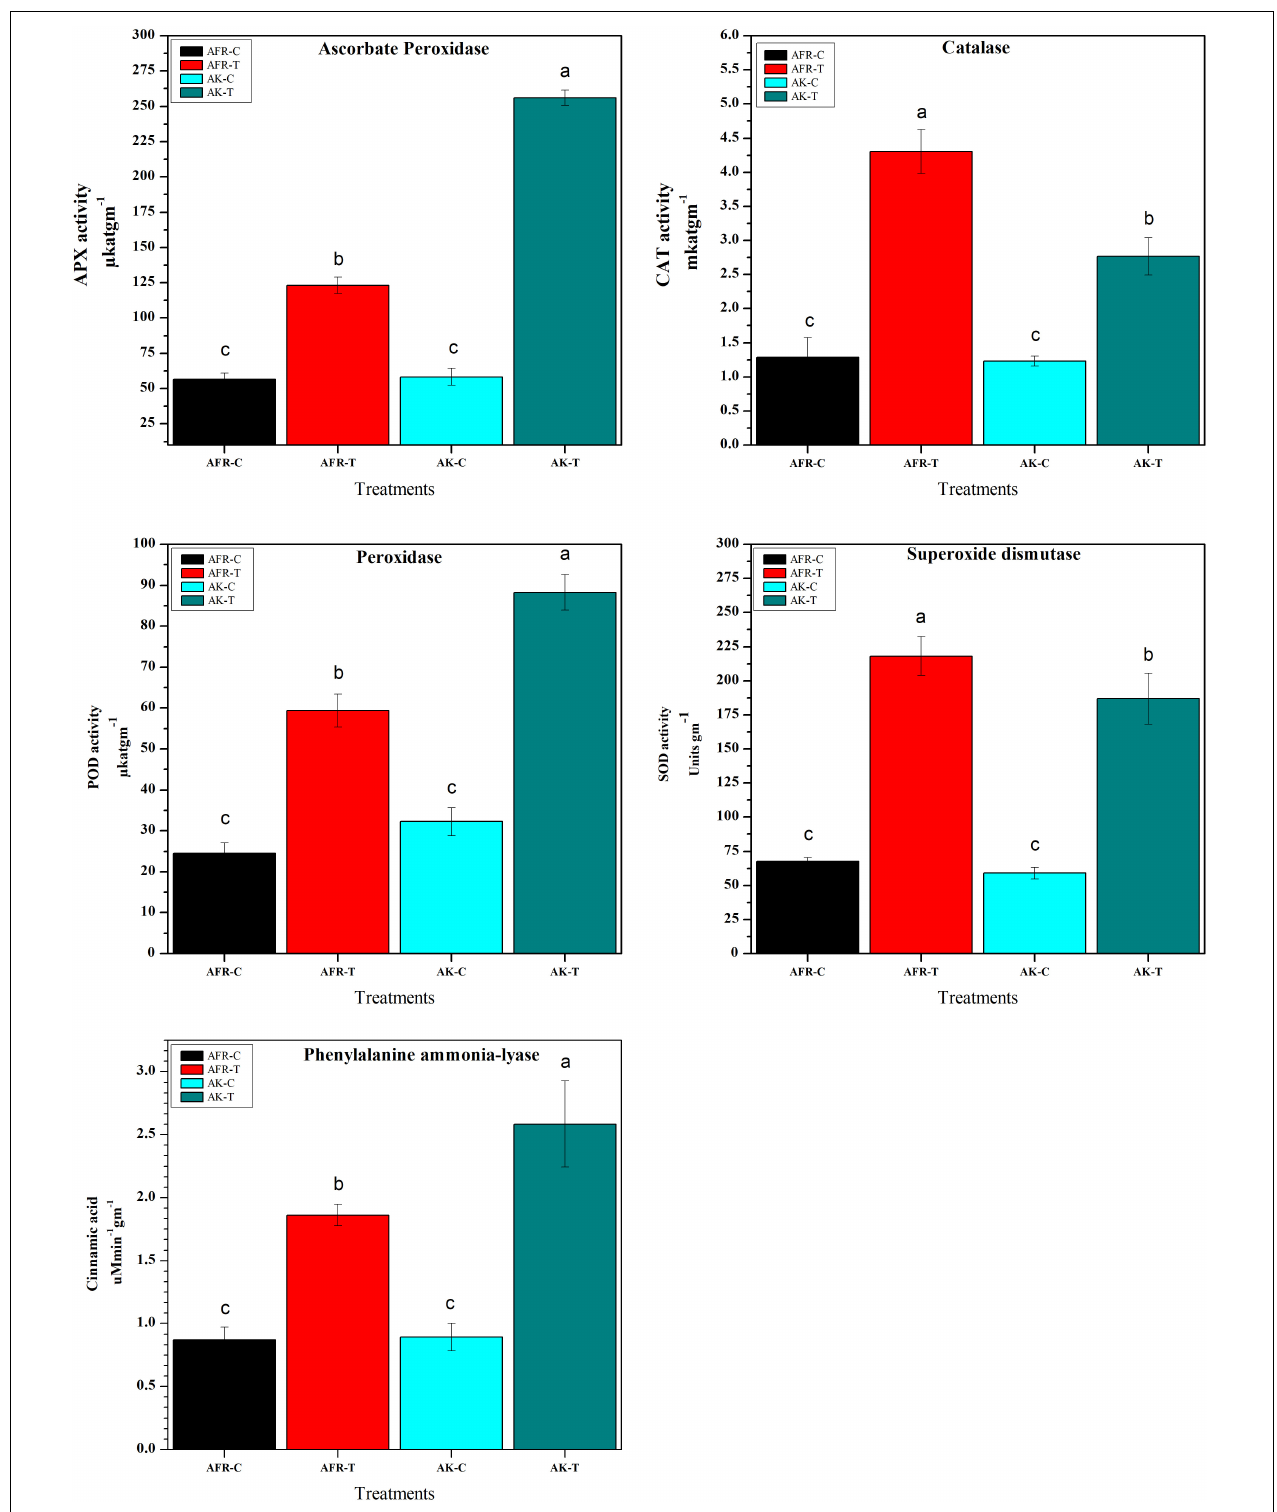
FIGURE 5 | Effects of Alternaria porri infection on resistant and susceptible onion antioxidant and defense enzymes at 5 dpi. Data refer to the most representative of two independent repeated experiments. Values are expressed as the average of three biological replicates, each consisting of three plants pooled together. Error bar showed the standard error of the mean, and different letters suggest statistically significant differences as per Duncan’s multiple range test ( p < 0.05).